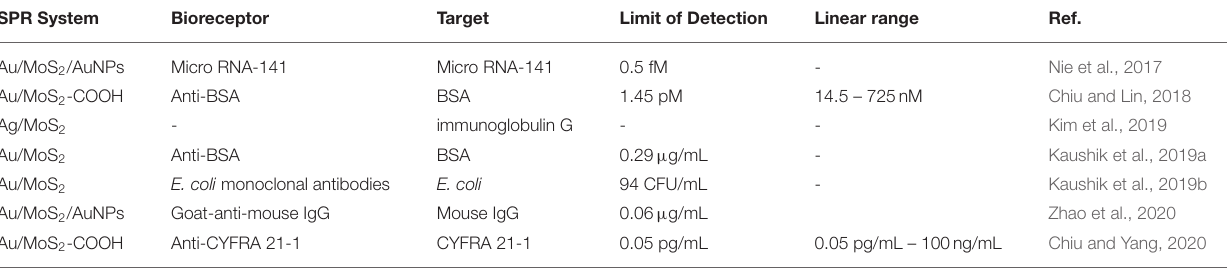
TABLE 3 | Molybdenum disulfide-based SPR biosensor design, detection limits, and the resulting linear range.